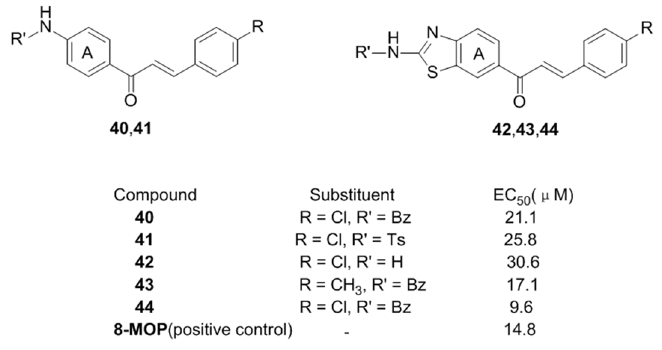
Figure 8. Structures of the benzothiazole and amide chalcones.